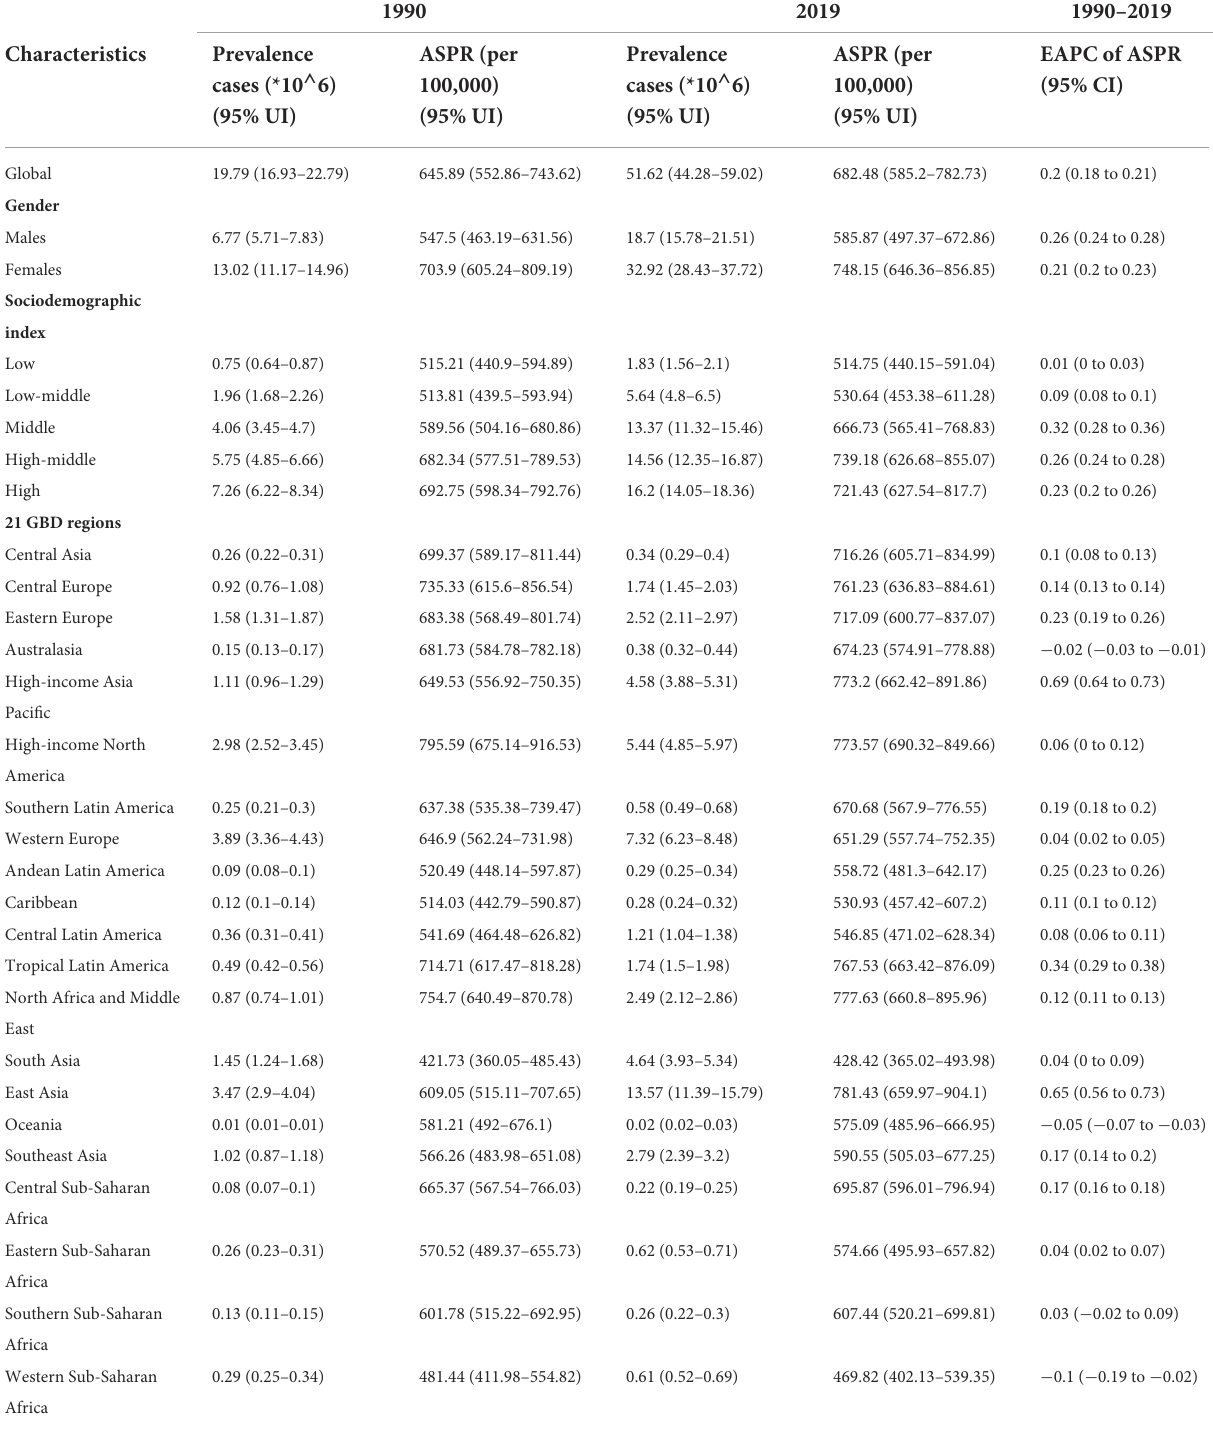
TABLE 2 The number of prevalence cases and ASPR of Alzheimer’s disease and other dementias in 1990 and 2019 and its